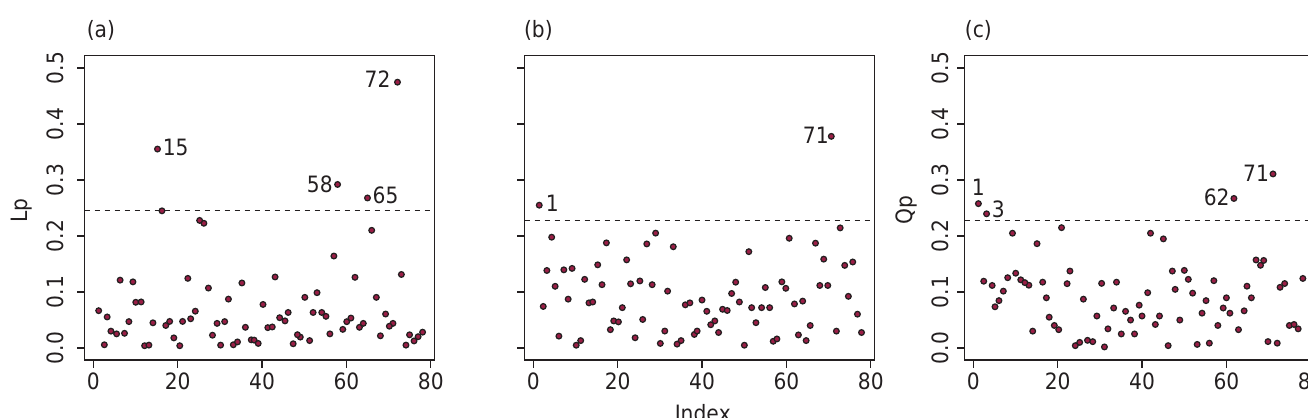
Figure 3. Graphs of local influence perturbing the linear predictor considering: (a) the Gaussian spatial linear model (GSLM) and measure L